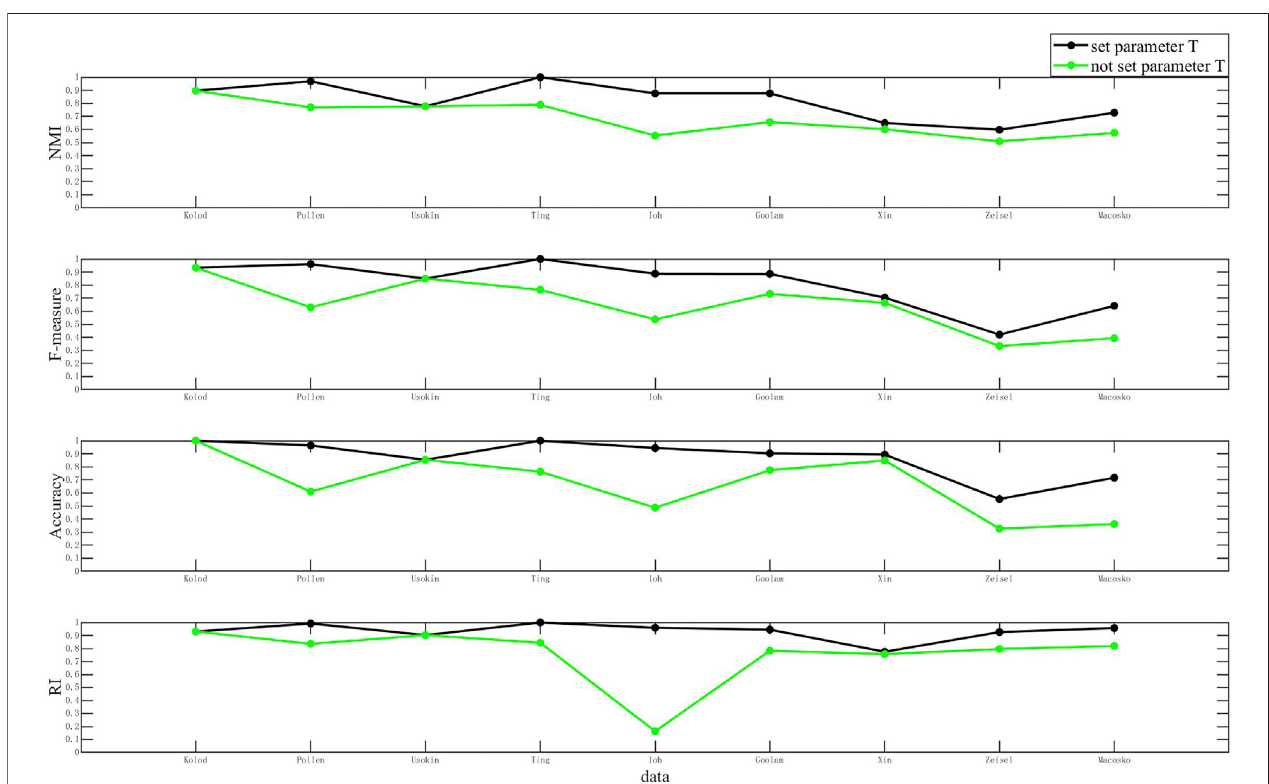
FIGURE 8 | Clustering results when T and not T are set.